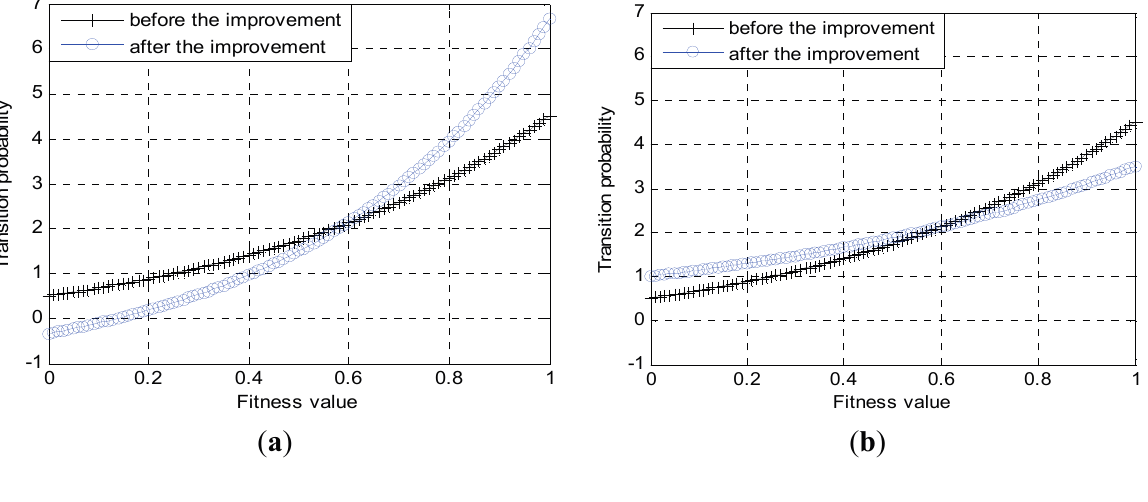
Figure 4. ( a ) Adjustment of transition probability ( c is small); ( b ) Adjustment of transition probability ( c is large).